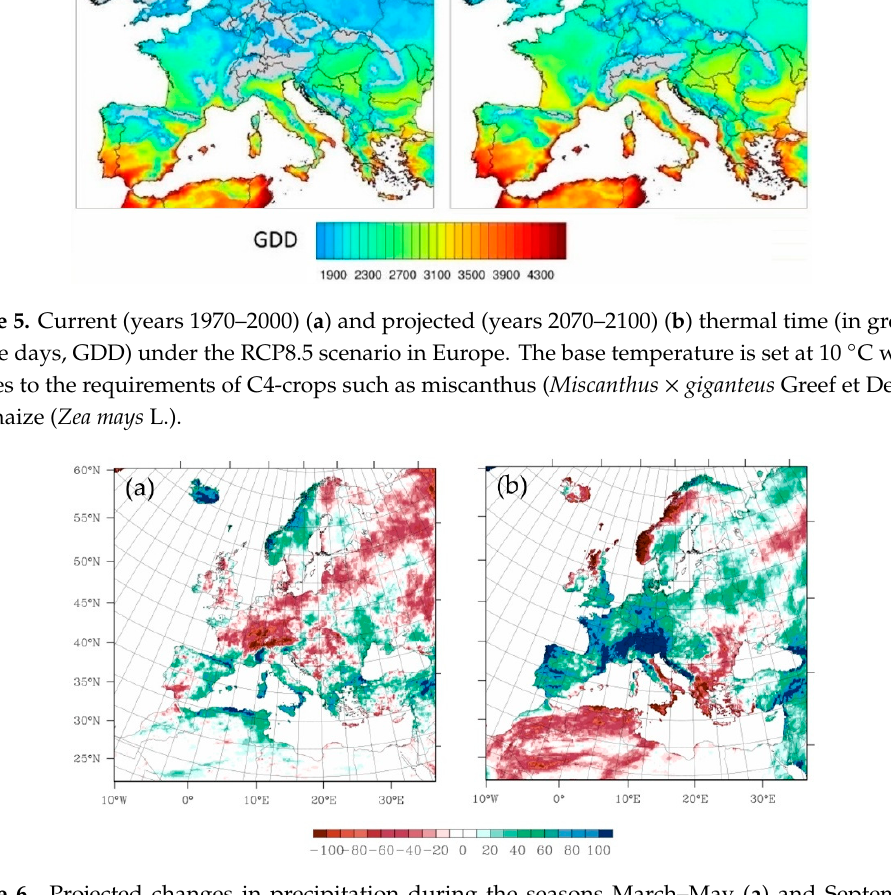
Figure 6. Projected changes in precipitation during the seasons March–May ( a ) and September– Figure 7 November ( b ) until 2050 given a RCP8.5 scenario. Data based on EC-EARTH–CCLM